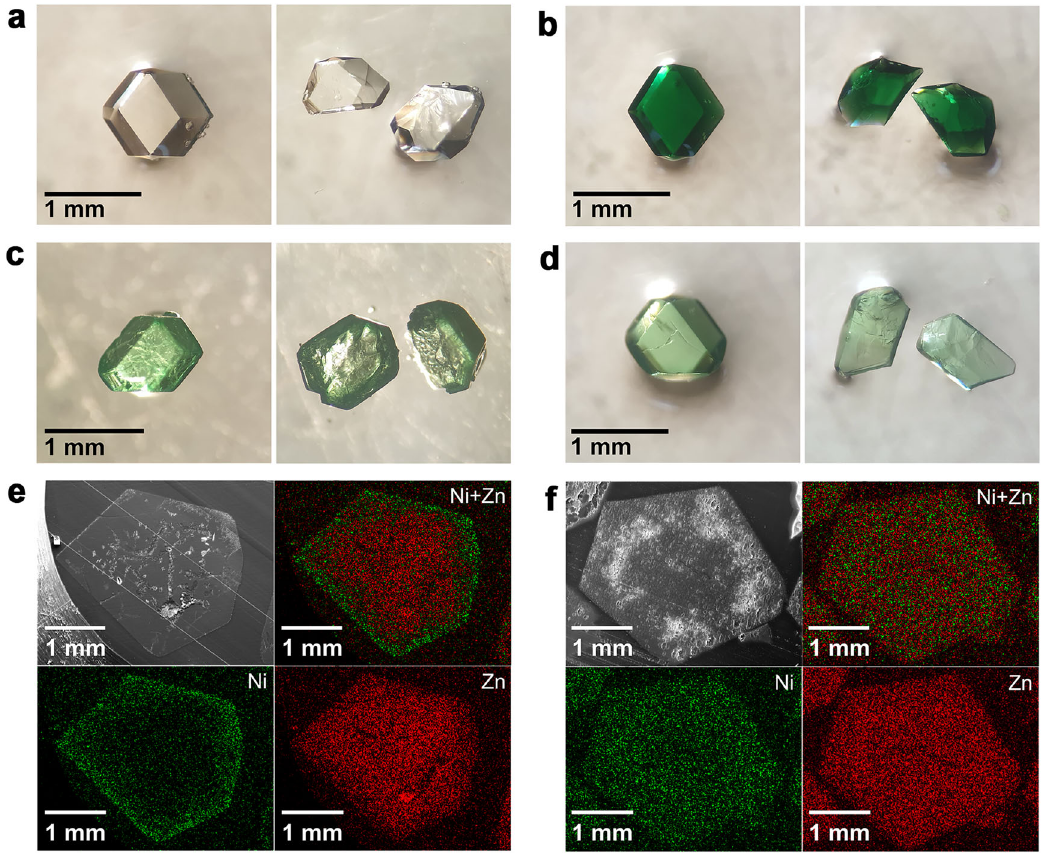
Fig. 6 Optical photographs, SEM images and EDS maps of core – shell ITHD(Zn)@ITHD(Ni) and uniform ITHD(Zn) – ITHD(Ni) crystals. a Optical photographs of as-synthesized ITHD(Zn) single crystal and its fragments. b Optical photographs of ITHD(Ni) single crystal obtained via PSE and its fragments. c Optical photographs of ITHD(Zn)@ITHD(Ni) 0.30 (100,20m) core – shell crystal and its fragments. d Optical photographs of ITHD(Zn) – ITHD(Ni) 0.17 (5,4d) uniform crystal and its fragments. e SEM image and EDS maps of cross-sectioned ITHD(Zn)@ITHD(Ni) 0.30 (100,20m) crystal showing core – shell distribution of metal ions. f SEM image and EDS maps of cross-sectioned ITHD(Zn) – ITHD(Ni) 0.17 (5,4d) crystal showing uniform distribution of metal